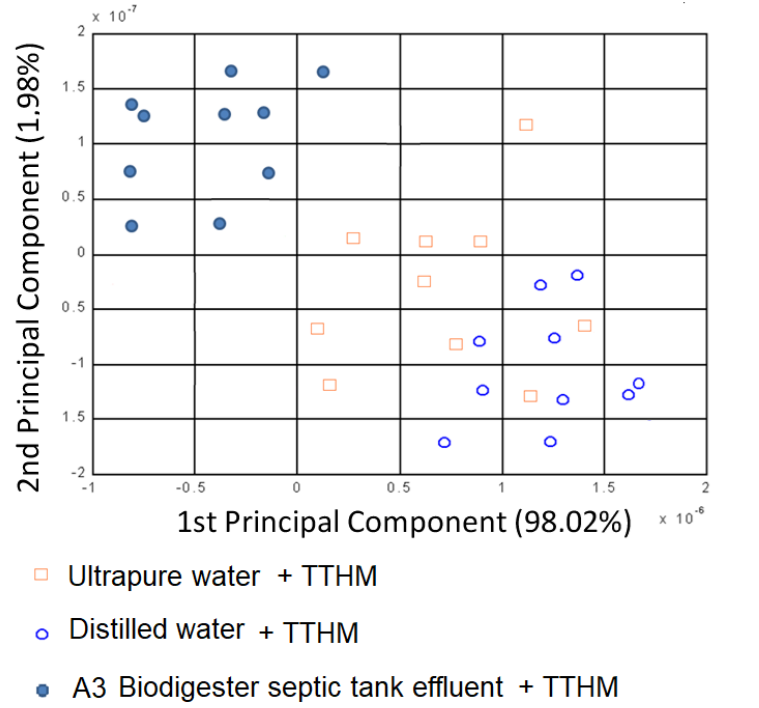
Fig. 10. Sensory analysis obtained for samples of ultrapure water, distilled water and effluents from a biodigestor septic tank (sam- ple A3) contaminated by TTHM.